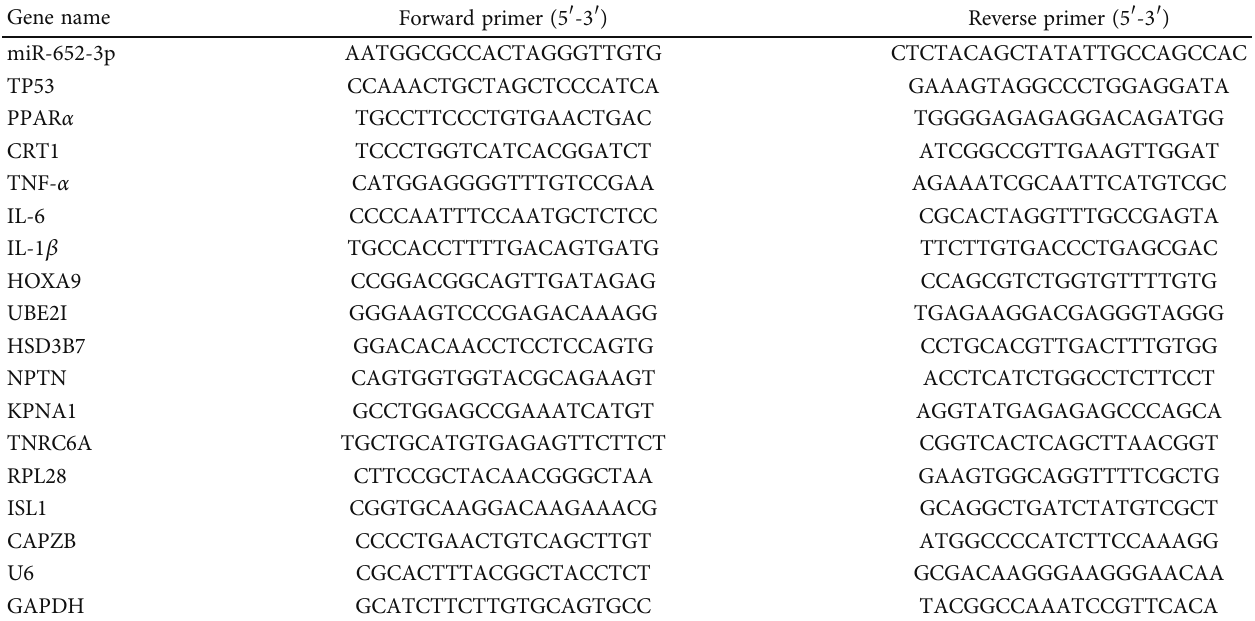
Table 1: Primer sequence